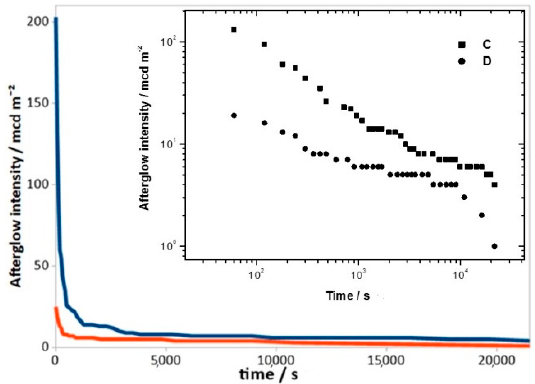
Figure 2. Decay curves of samples C (blue) and D (red). The upper inset showed the log-log plot.